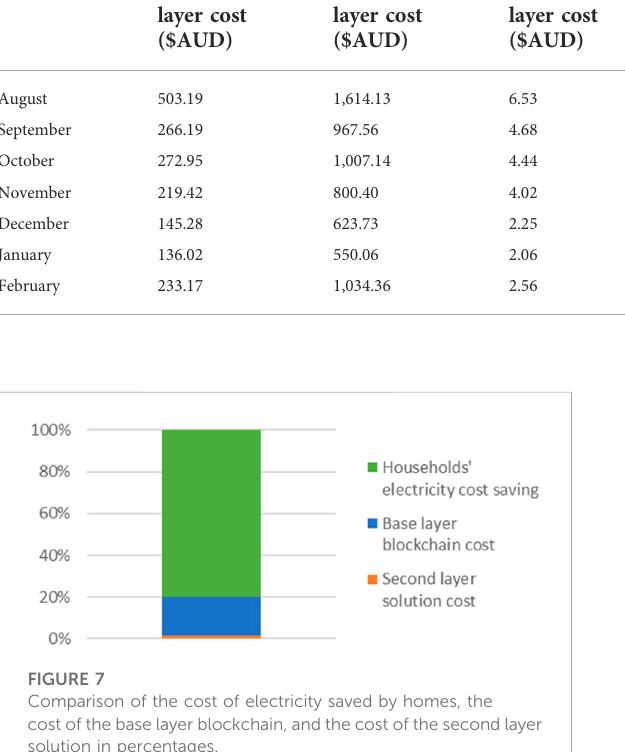
TABLE 1 A comparison in terms of the expenses of a base layer blockchain solution to the costs of a second layer blockchain solution. Month